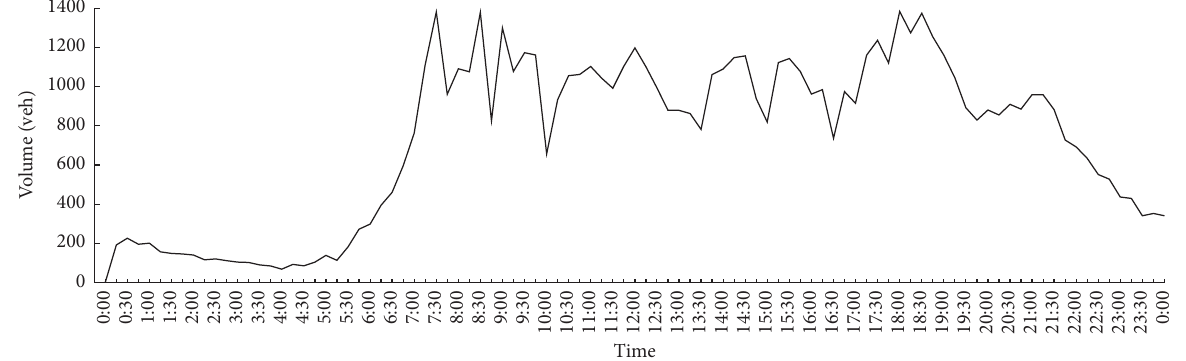
Figure 5: Trafc-fow data of 24 h in a working day at Jiuhua road and Zheshan road intersection.